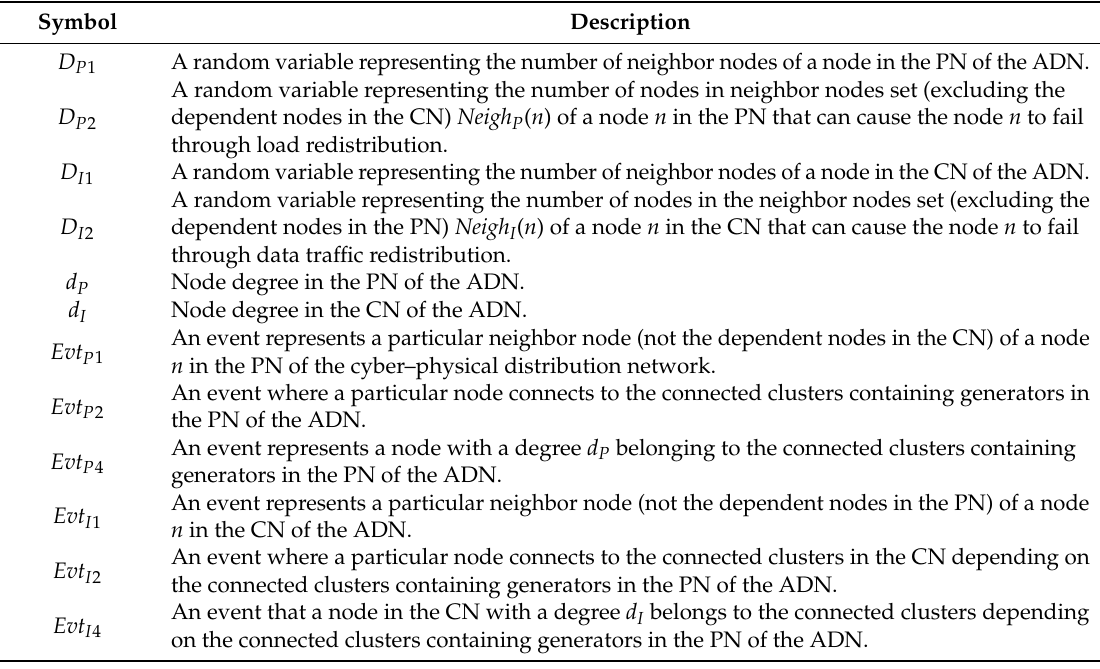
Table A1. Symbolic Descriptions used in Appendices